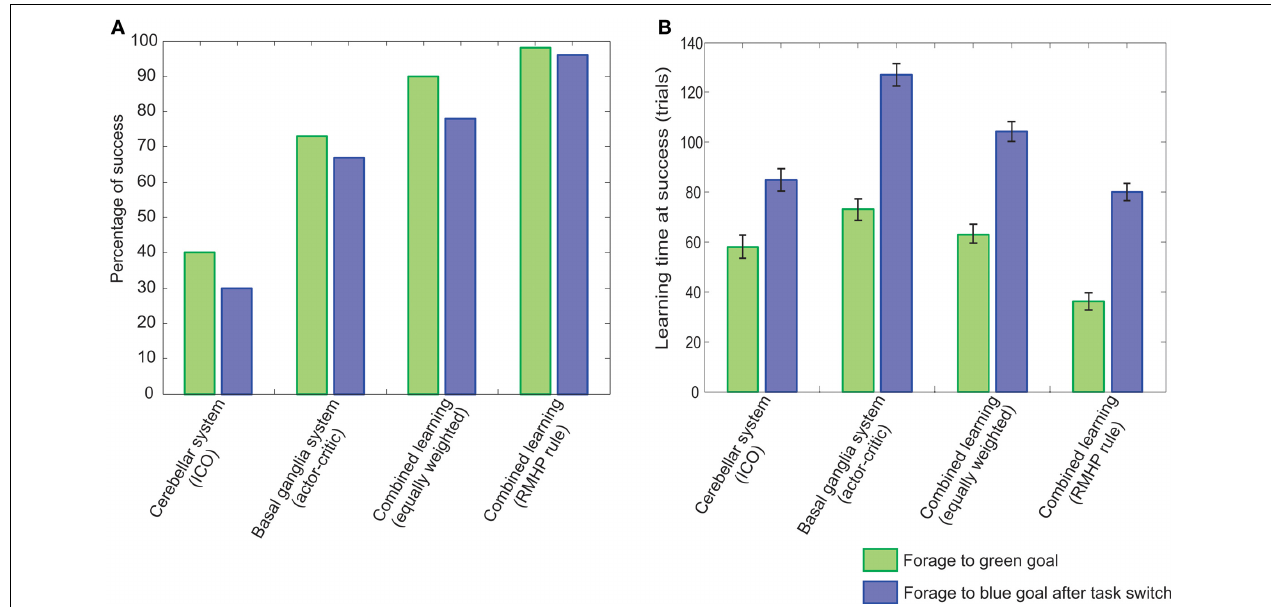
FIGURE 12 | Comparison of performance of RMHP modulated adaptive comninatorial learning system for the dynamic foraging task. (A) Percentage of success measured over 50 experiments. (B) Average learning time (trials needed to successfully complete the task, calculated over 50 experiments